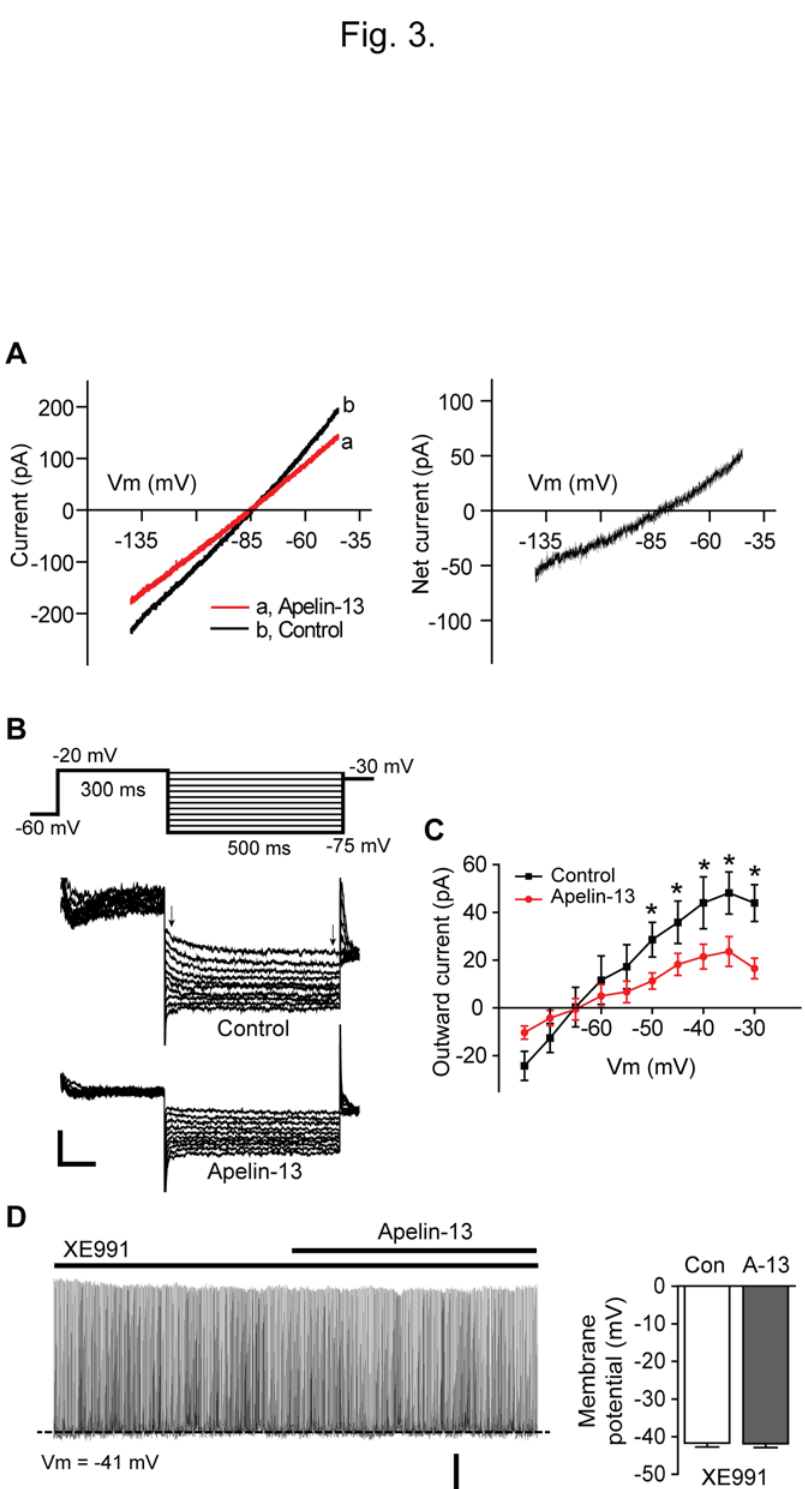
Fig 3. Apelin-13 inhibits M-type potassium current. (A) Current-voltage (I-V) relationship of the apelin- sensitive current. Left panel shows the whole-cell membrane currents in response to ramping the membrane potential from -140 mV to -30 mV before and after application of apelin-13 (100 nM). Right panel: The I-V relationship shows that the reversal potential of the apelin-sensitive current was -84.3 ± 1.4 mV (n =